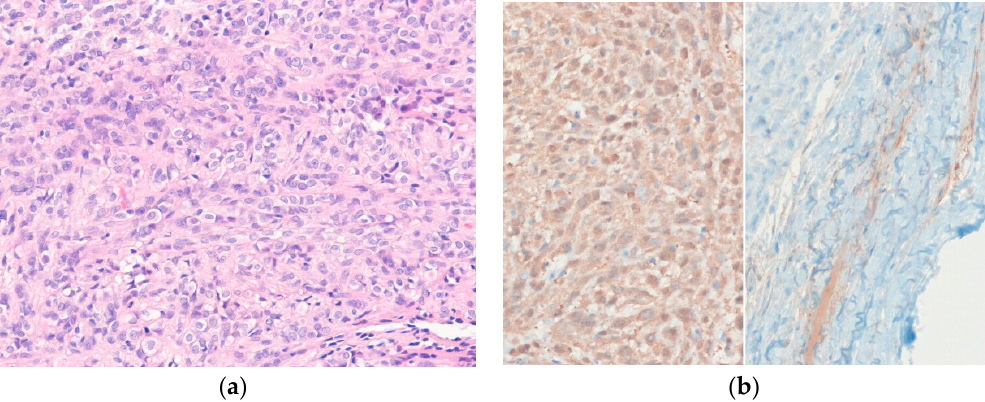
Figure 4. Epithelioid schwannoma. ( a ) The bland epithelioid tumor cells are arranged in sheets and nests; ( b ) The tumor cells are diffusely positive for S100 protein (left). EMA highlights the perineurial capsule (right) (H&E stain, original magnification 200× ( a ); S100 protein and EMA immunostain, original magnification 200× ( b )).